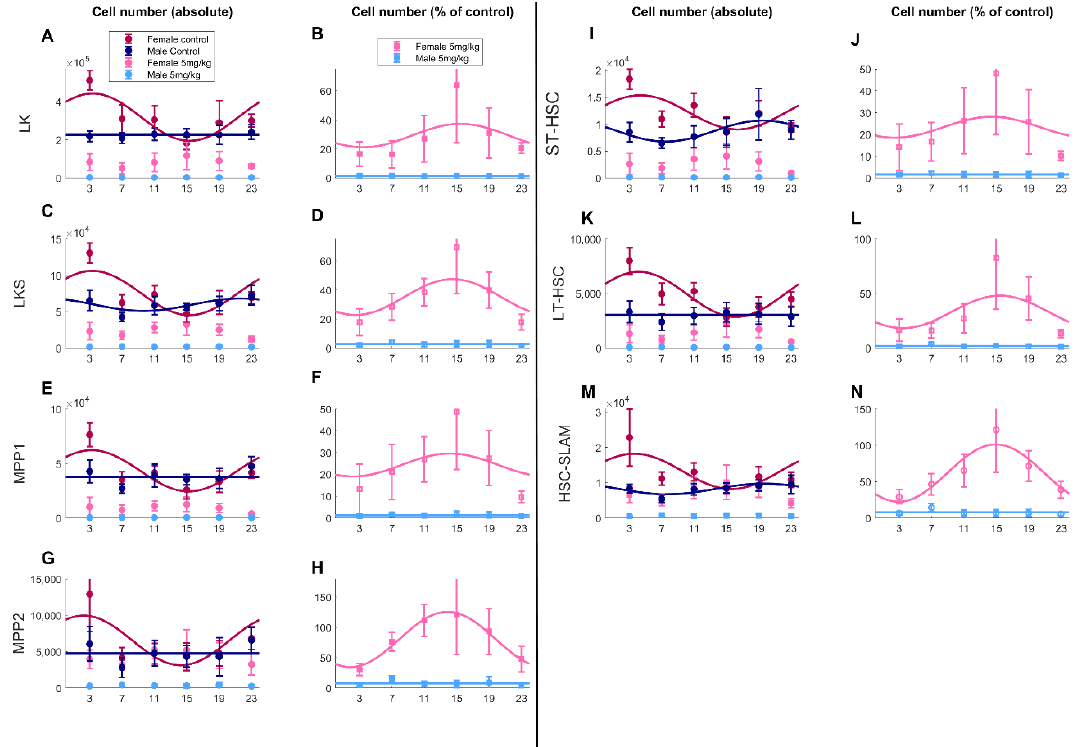
Figure 5. Sex and timing-dependent bone marrow progenitor cell numbers for the seven studied populations. Panels ( A , C , E , G , I , K , M ) show cell numbers in control (datapoints, mean ± SD) and treated (bars) conditions. Panels ( B , D , F , H , J , L , N ) show ratios between treated and control conditions (datapoints, mean ± SD). On all panels, solid lines are the best-fit significant cosine curves.